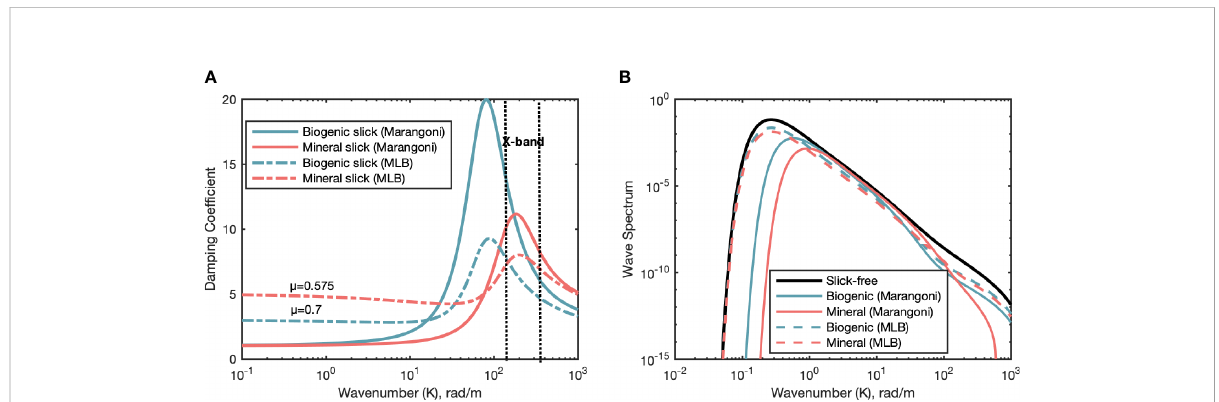
FIGURE 2 (A) Spectral damping coef fi cient related to a biogenic fi lm (blue line) and a crude oil (red line) slick evaluated using the Marangoni – continuous line – damping model y Mar and the MLB dashed – dotted line – damping model y MLB . Note that the range of X-band Bragg wavenumbers is enclosed by the dotted black vertical lines. (B) Roughness spectrum of a slick-free (black line), biogenic slick-covered (blue line) and crude oil- covered (red line) sea surface. Note that the continuous lines represent S s,Mar while the dashed lines representing S s,MLB